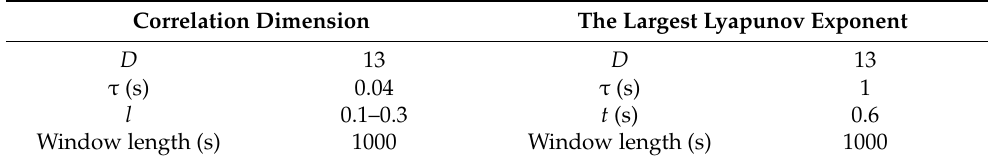
Table 2. Parameters of the methods for calculating the correlation dimension and the largest Lyapunov exponent.